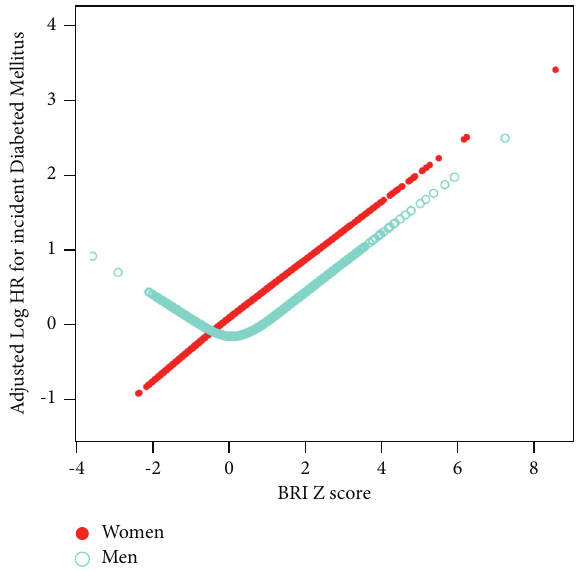
Figure 1: Dose-response relationship between BRI and incident T2DM by gender in the NAGALA study. The solid dots indicate the estimated risk of incident T2DM in women, and the hollow dots represent the estimated risk of incident T2DM in men adjusted for age, alcohol intake, smoking status, fatty liver, SBP, FPG, HbA1c, HDL-C, TG, and TC. BRI, body roundness index.